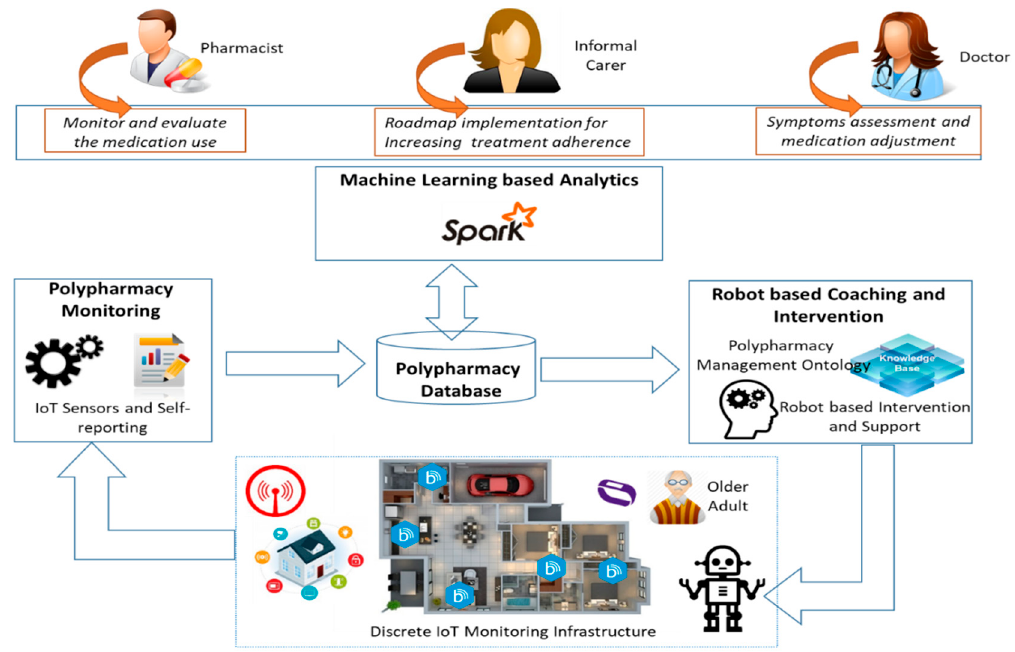
Figure 1. Assistive technologies use to implement the polypharmacy management service.